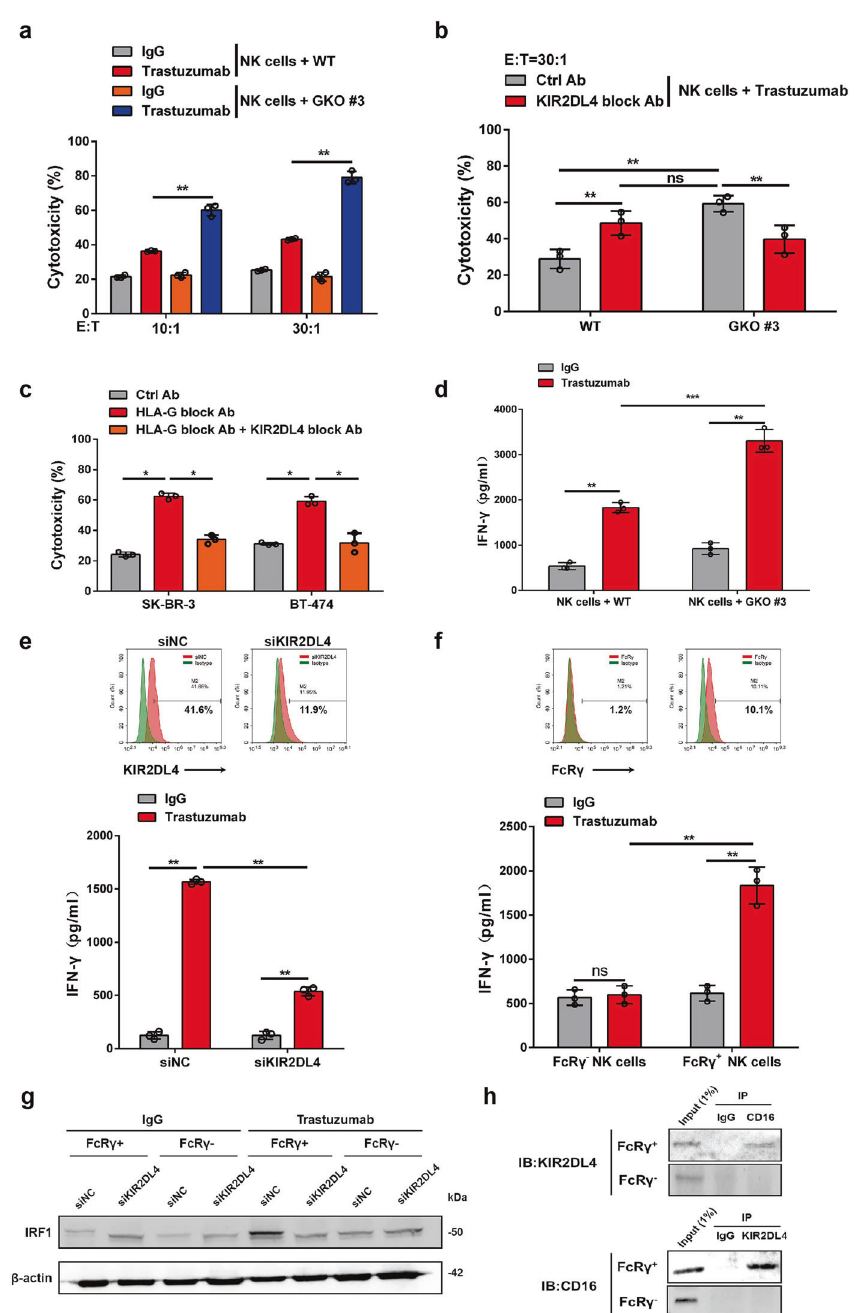
Fig. 3 HLA-G-unbound KIR2DL4 promotes ADCC and IFN- γ production by NK cells. a NK cells in the presence of trastuzumab were cocultured with WTor HLA-G-knockout (GKO #3) SK-BR-3 cells supplemented with trastuzumab or IgG. The cytotoxicity of NK cells was measured via FCM. b NK cells were cocultured with WT or GKO #3 SK-BR-3 cells in the presence of trastuzumab alone or together with the indicated antibodies, and the cytotoxicity of NK cells was determined. c NK cells were cocultured with breast cancer cells in the presence of trastuzumab and the indicated blocking antibodies, and the cytotoxicity of NK cells was measured by FCM (E:T = 30:1). d NK cells were cocultured with WT or GKO #3 SK-BR-3 cells (E:T = 1:1) supplemented with trastuzumab or IgG. IFN- γ production was measured via ELISA. e NK cells transfected with control or KIR2DL4 siRNAs were subjected to FCM assay (upper). Cells were cocultured with GKO #3 SK-BR-3 cells and treated with IgG or trastuzumab, and IFN- γ production was measured via ELISA (lower). f – h NK cells from healthy donors were subjected to FACS according to FcR γ expression ( f , upper). The FcR γ + and FcR γ - cells were then cocultured with GKO #3 SK-BR-3 cells plus treatment with IgG or trastuzumab, and were subjected to enzyme-linked immunosorbent assay (ELISA) ( f , lower), Western blot analysis ( g ), and immunoprecipitation assay ( h ). All experiments were performed three times. Statistical signi fi cance was determined by Student ’ s t test. * P < 0.05, ** P < 0.01, and *** P < 0.001. n.s. Nonsigni fi cant